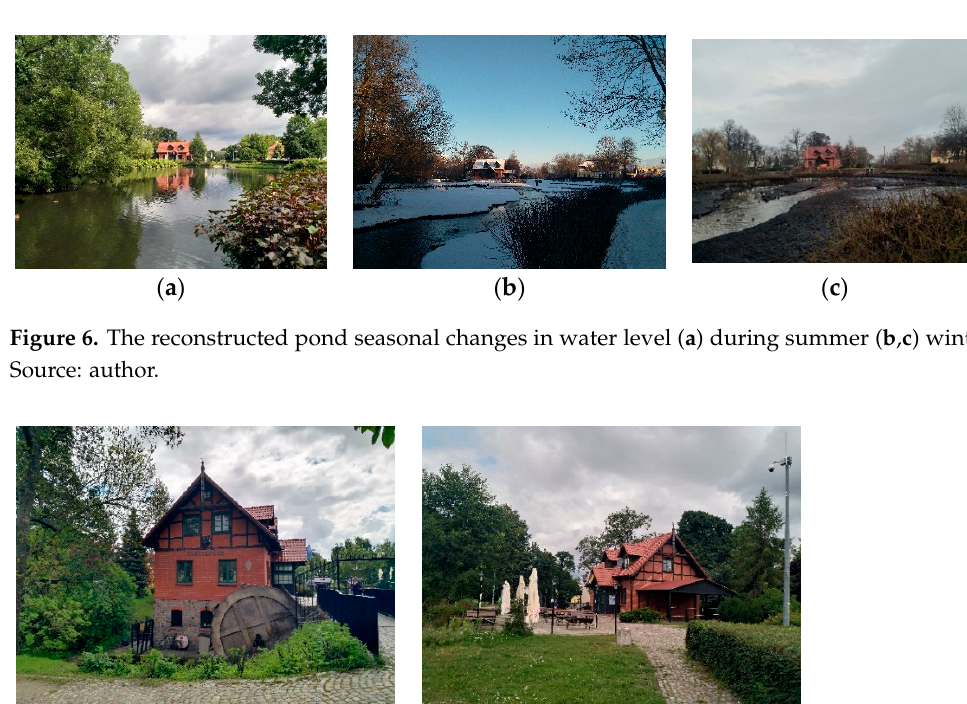
Figure 5. Location of water smithy and ponds: ( a ) map from XIX century, source: digital archives [21]; ( b ) map from 1938, source [22]; ( c ) historic airplane photo from the IIWW, source [23]; ( d ) historic orthophoto map from 1997, source [23]; ( e ) 2005, digital archives of the city of Rumia, source [23]; ( f ) today, orthophoto map, source: [12].